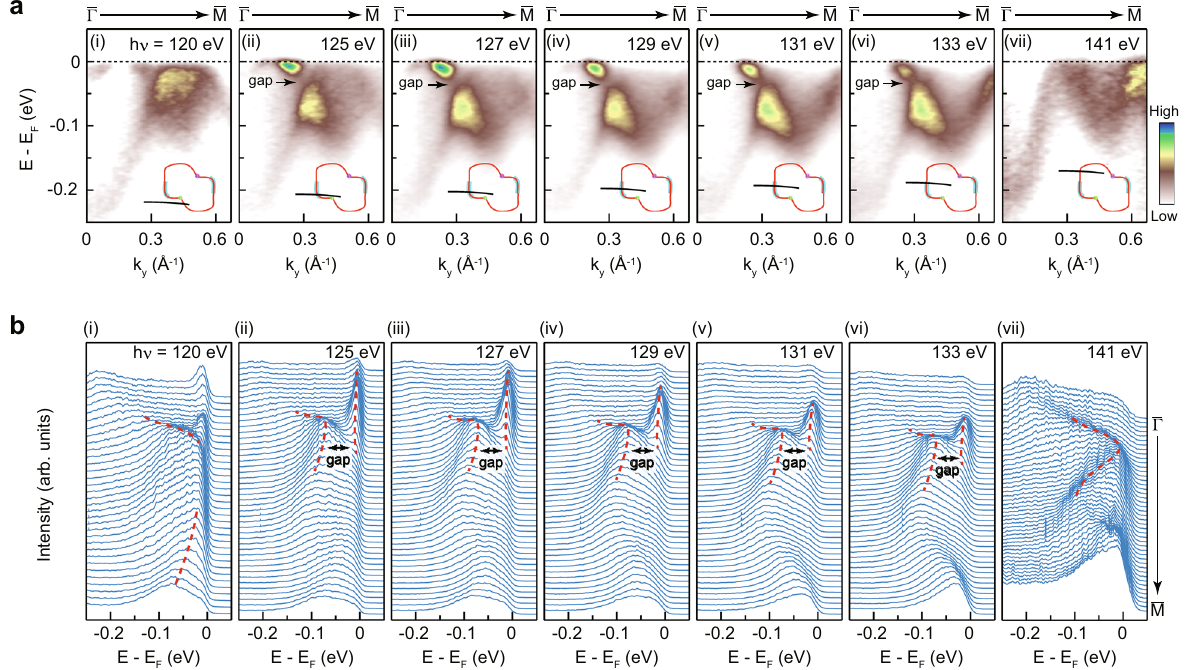
Fig. 3 Observation of the SOC-induced gap structure along the nodal line in Co 3 Sn 2 S 2 . a The band structure along Γ M direction taken at different photon energies. The measured position on the nodal line is marked by the black line in the inset of each panel. When the measured points locate out of the cyan region on the nodal line (i, vii), the gapped nodal line lies above E F that can not be observed experimentally. Upon moving the measured point into the cyan region, the gapped nodal line lies below E F , that are clearly observed experimentally as illustrated by the arrows in (ii – vi). b The corresponding energy distribution curves (EDCs) of ( a ). The SOC-induced gap is characterized by the separation of the two branches of bands in (ii –